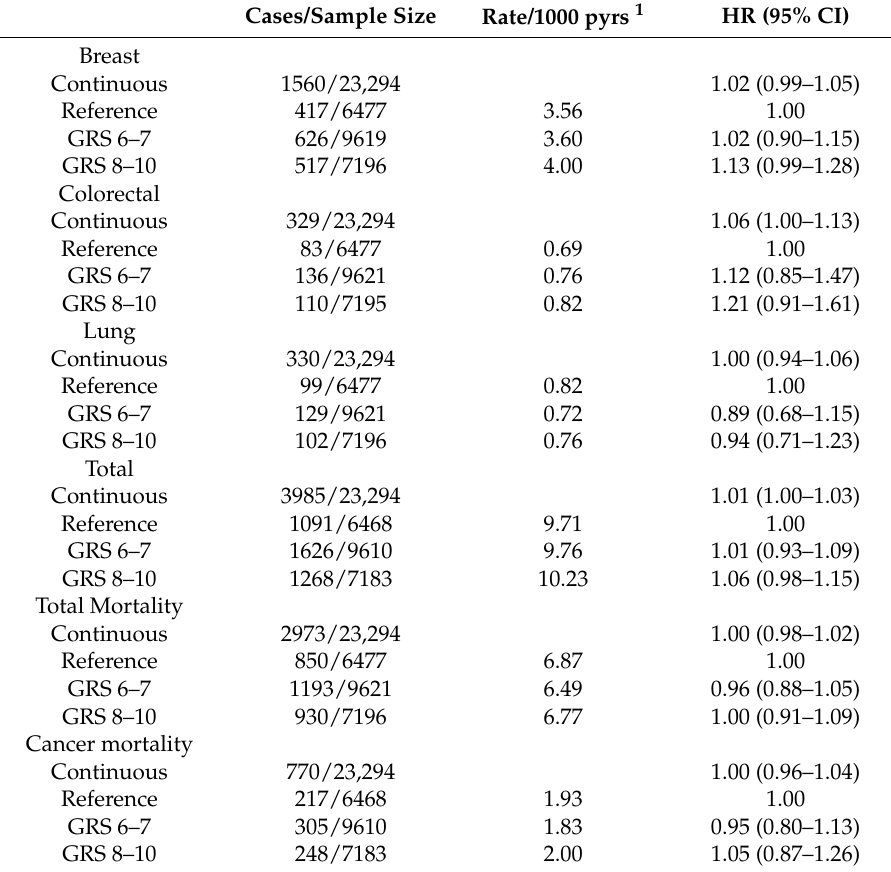
Table 2. Cox proportional hazards for cancer and mortality for genetic risk score of alleles associated with an increase in circulating 25OHD (continuous and categorical)